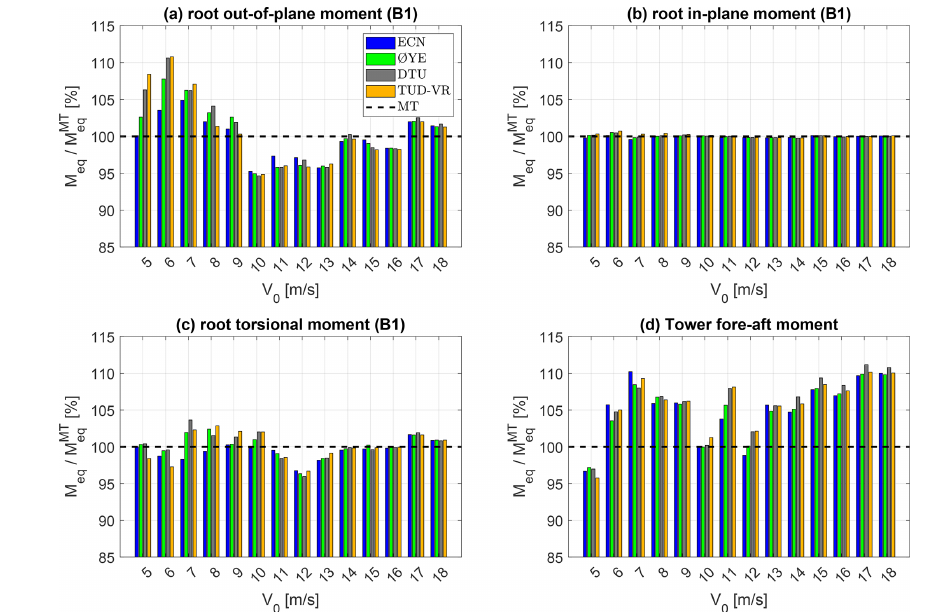
Figure B1. Here the results obtained with the original controller considering six seeds per wind speed (only the average value among the seeds is plotted) are reported in similar plots to those shown in Fig.